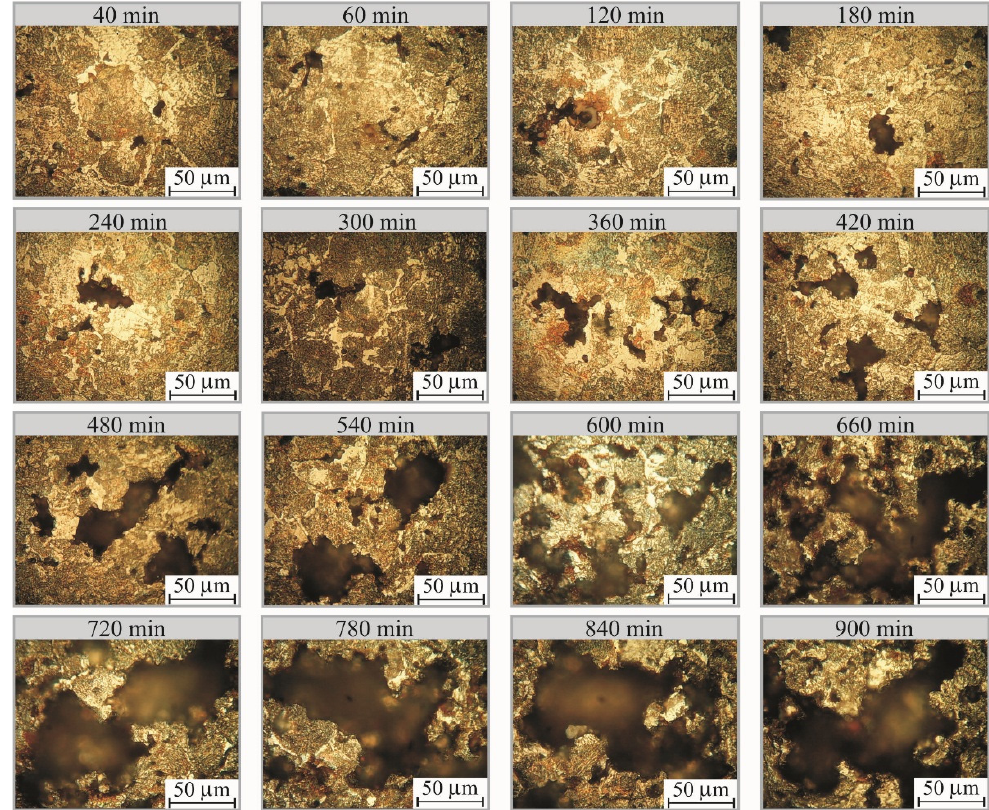
Figure 3. Dynamics of changes in the microstructure of 45 steel after ultrasonic treatment.